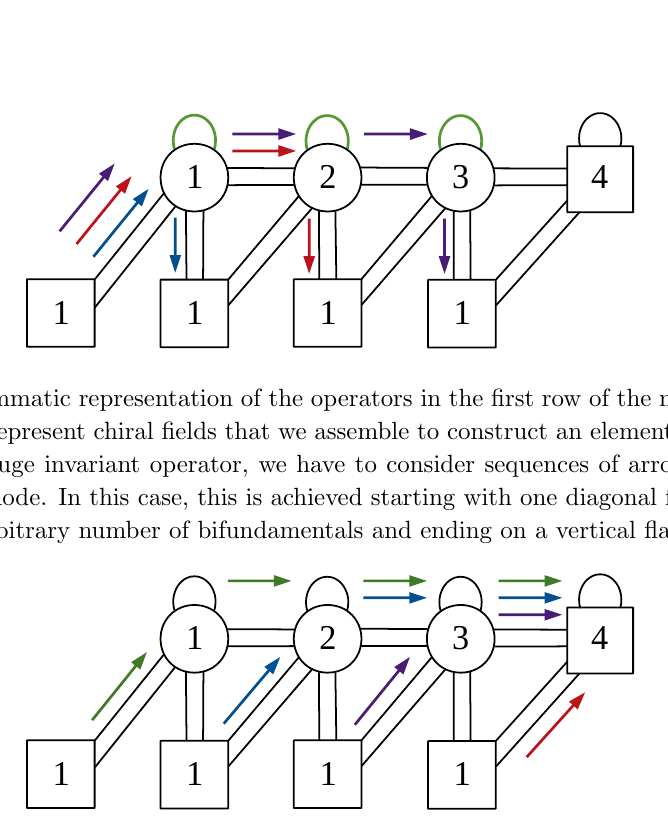
Figure 8 . Diagrammatic representation of the operator (cid:5). In this case, gauge invariant oper- ators are obtained starting with one diagonal (cid:13)avor, going along the tail with all the remaining bifundamentals and ending on the bifundamental connected to the last (cid:13)avor